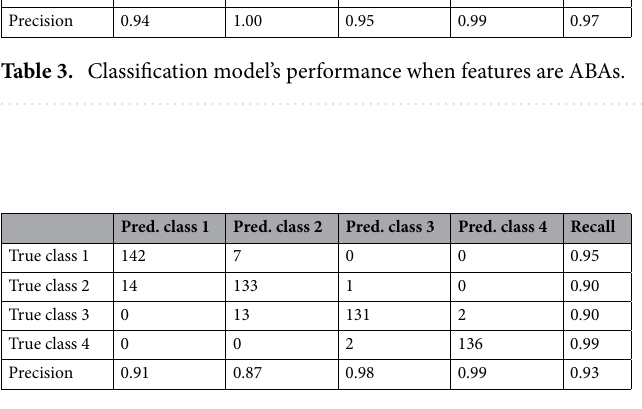
Table 4. Classification model’s performance when features are crossing nose